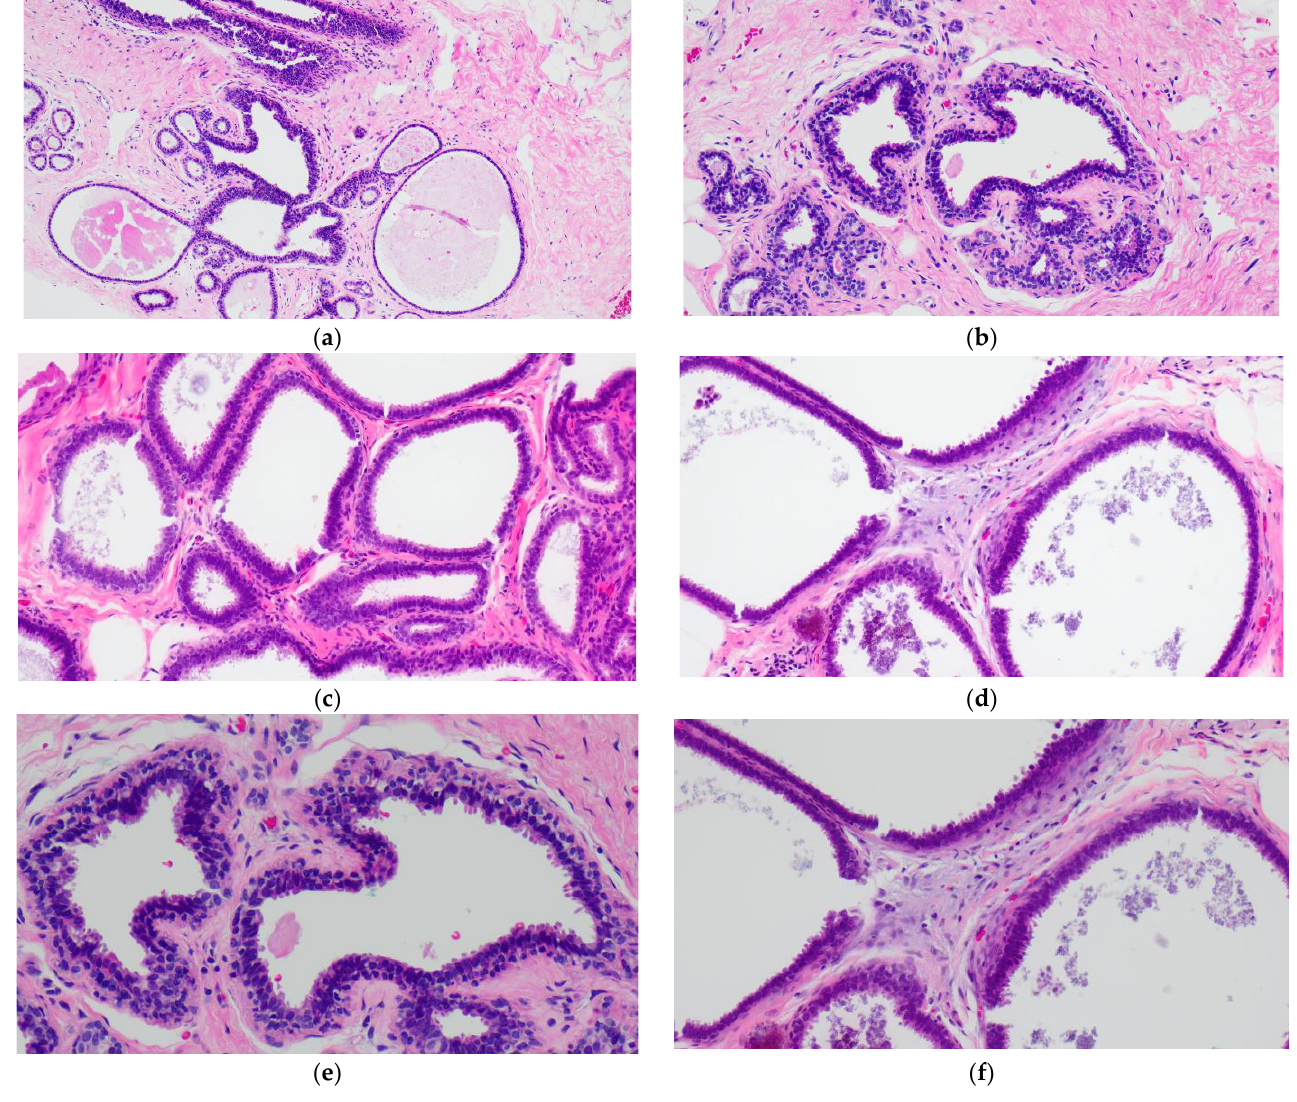
Figure 1. Columnar cell change (CCC) showing variably sized and shaped ( a , c ) acini lined by one to two layers of columnar-shaped epithelial cells with uniform, ovoid to elongated nuclei oriented perpendicular to the basement membrane; apical cytoplasmic snouts are seen at the luminal surface and an outer layer of myoepithelial cells is evident ( b , d – f ). There are luminal secretions ( a , c , d ) and calcifications ( d , f ).